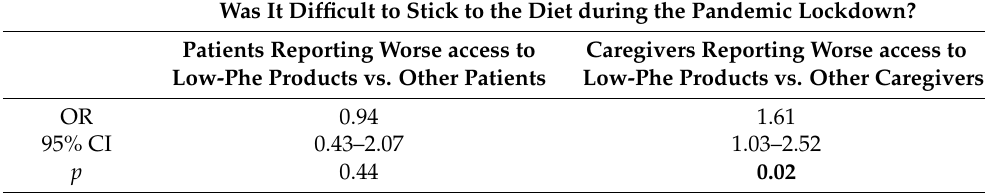
Table 7. The relationship between reporting worse access to low-phenylalanine (low-Phe) products during the pandemic lockdown and self-reported changes in Phe levels. Was It Difficult to Stick to the Diet during the Pandemic Lockdown? Patients Reporting Worse access to Caregivers Reporting Worse access to Low-Phe Products vs. Other Patients